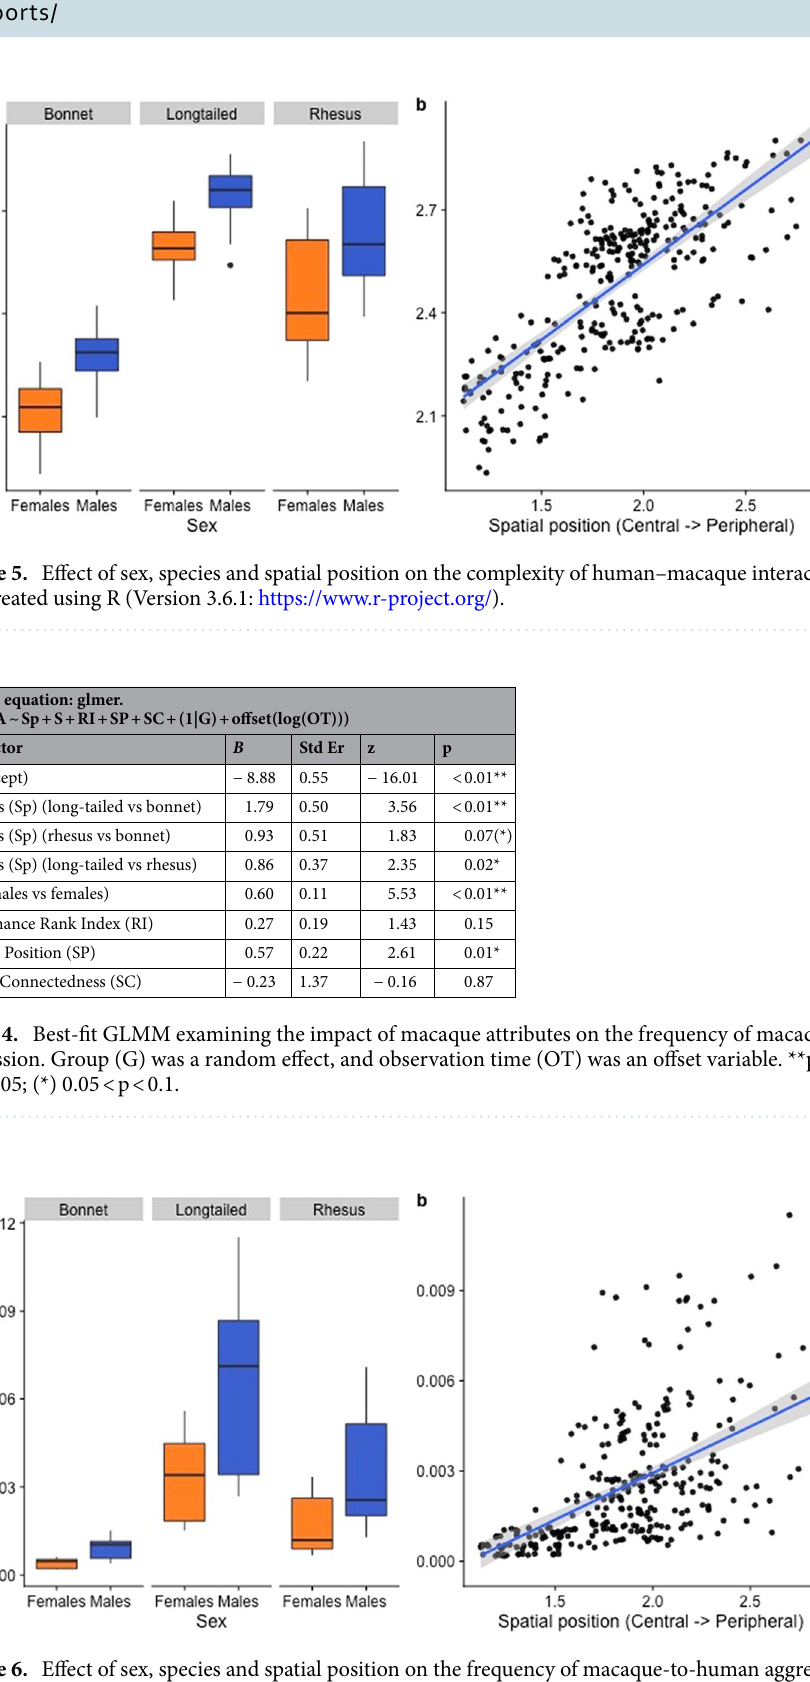
Figure 6. Effect of sex, species and spatial position on the frequency of macaque-to-human aggression. As with Fig. 2, the second grouping in the scatterplot represents individuals from the long-tailed macaque groups from Batu Caves 42 . Figure was created using R (Version 3.6.1: https ://www.r-proje